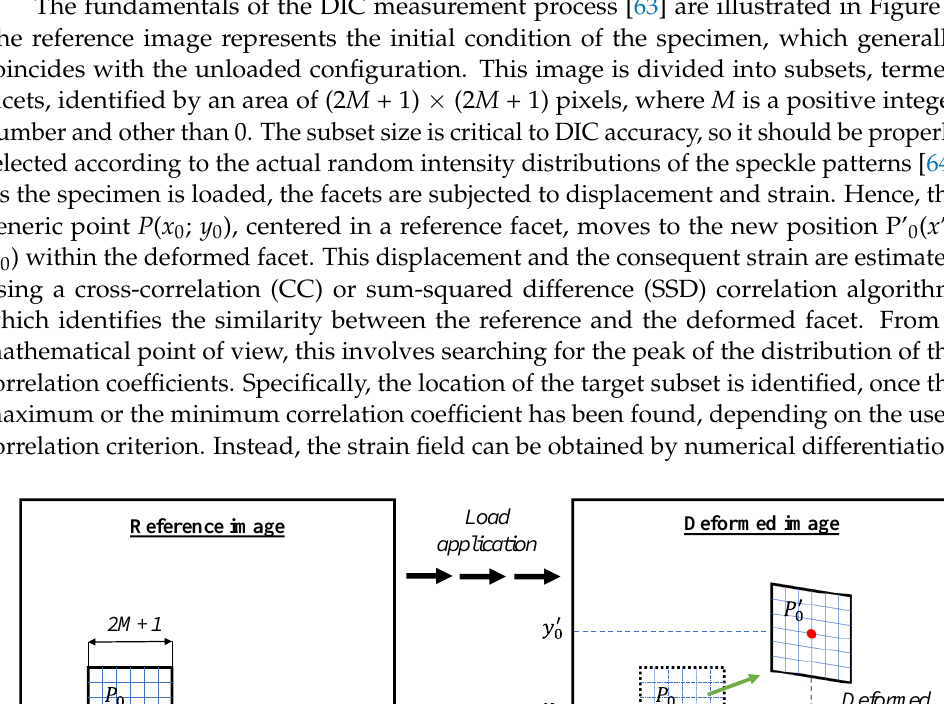
Figure 5. Schematic representation of the Digital Image Correlation (DIC) measuring process.